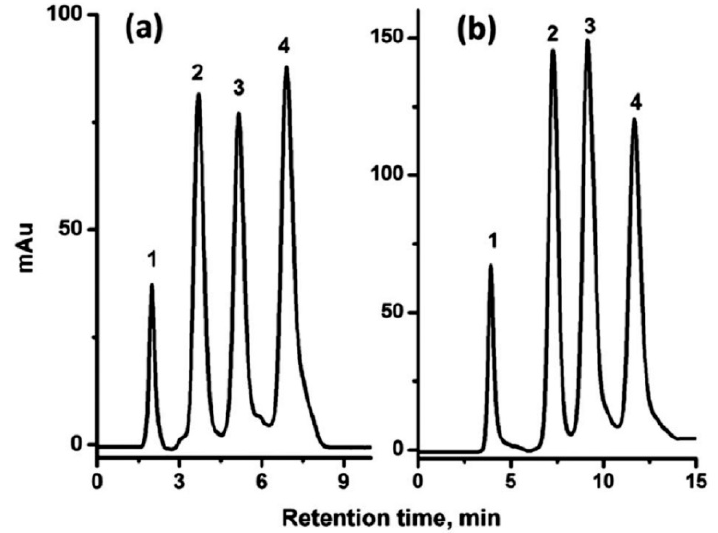
Figure 11. Reverse Phase separation of protein mixture on two different Lauryl methacrylate monoliths, ( a ) fabricated using photo-initiated polymerization and ( b ) fabricated via thermally initiated polymerization. Peaks are: (1) impurity; (2) ribonuclease A; (3) Cytochrome C; and (4) Myglobin. Reproduced from [85] with permission from The Royal Society of Chemistry.